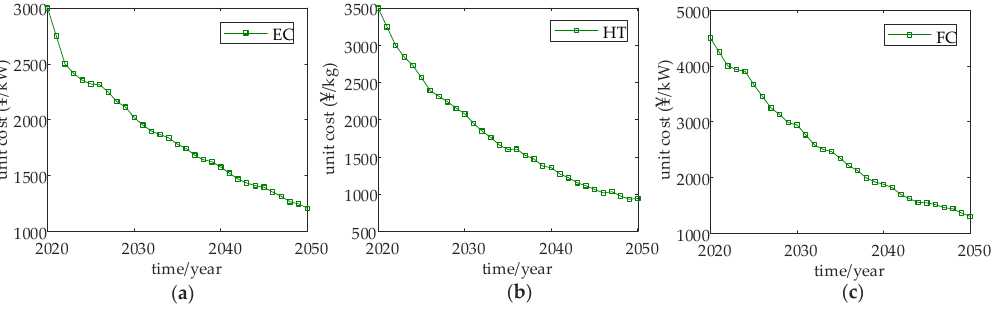
Figure 8. Forecasted price curves for hydrogen energy equipment from 2020 to 2050. ( a ) electrolytic cell; ( b ) hydrogen storage tank; ( c ) fuel cell.